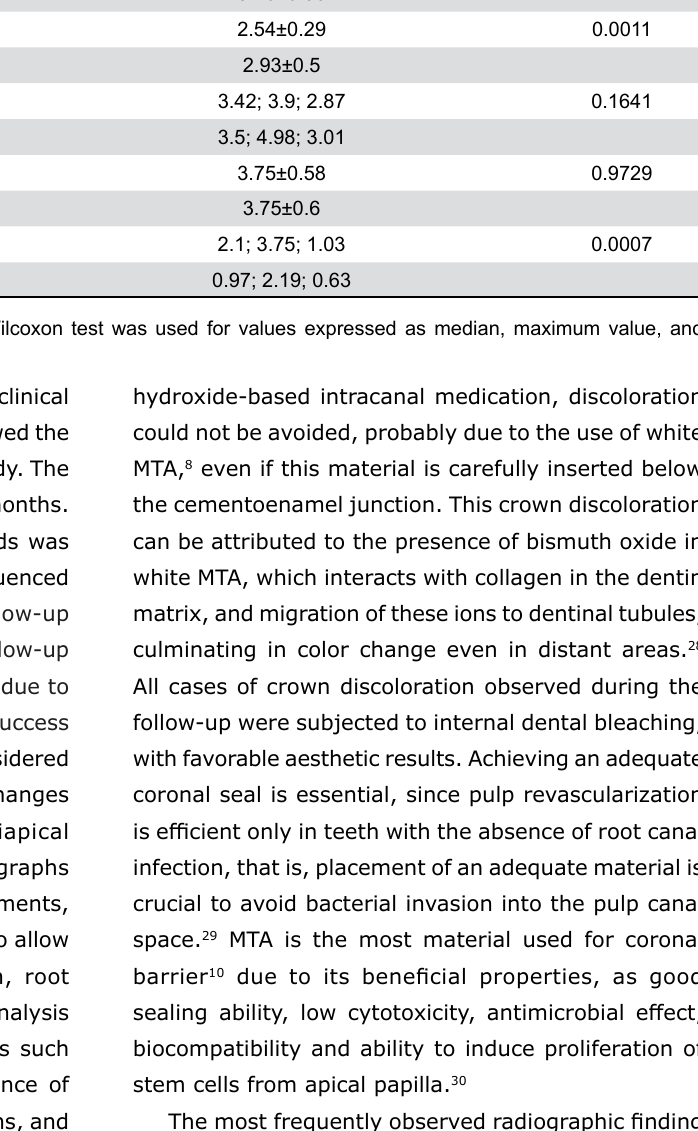
Treatment outcomes of pulp revascularization in traumatized immature teeth using calcium hydroxide and 2% chlorhexidine gel as intracanal Table 3- Quantitative radiographic outcomes